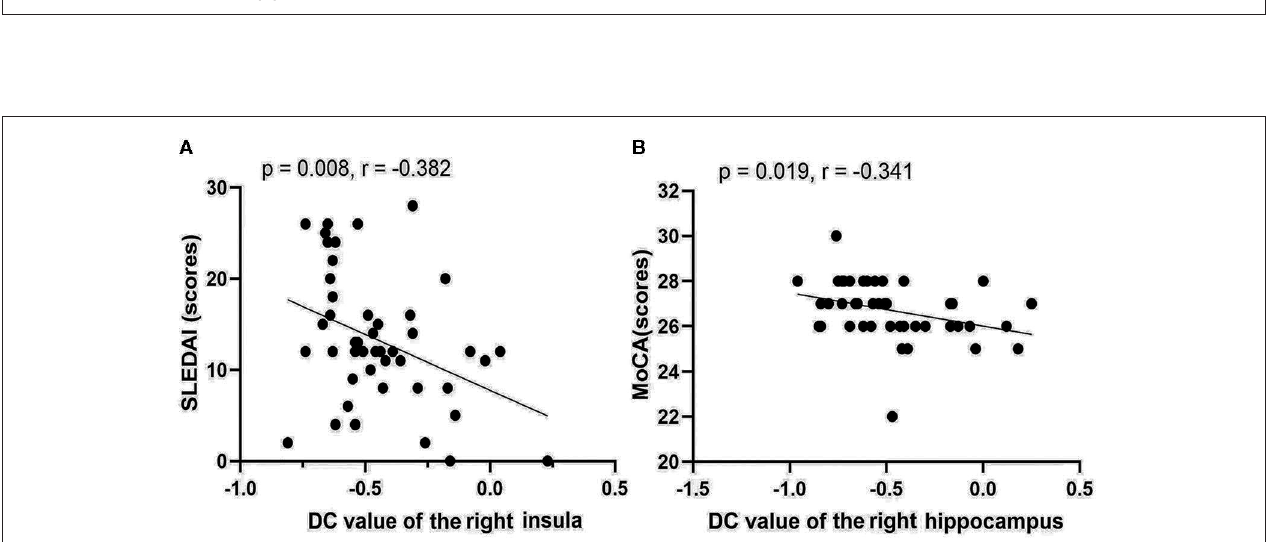
FIGURE 4 | Correlations among rs-fMRI data, clinical data, and neuropsychological test scores of non-NPSLE patients. (A) DC value of right insula vs. SLEDAI (scores). (B) DC value of right hippocampus vs. MoCA (scores) (SLEDAI, Systemic Lupus Erythematosus Disease Activity Index; MoCA, Montreal Cognitive